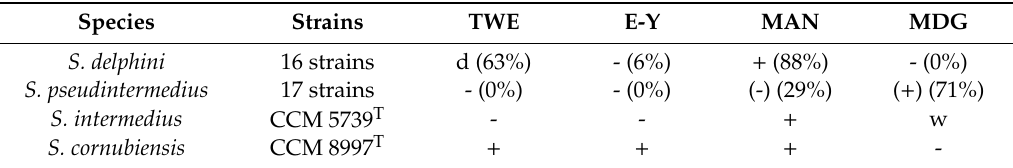
Table 2. Proposal of phenotypic traits suitable for di ff erentiation of Staphylococcus intermedius group species.